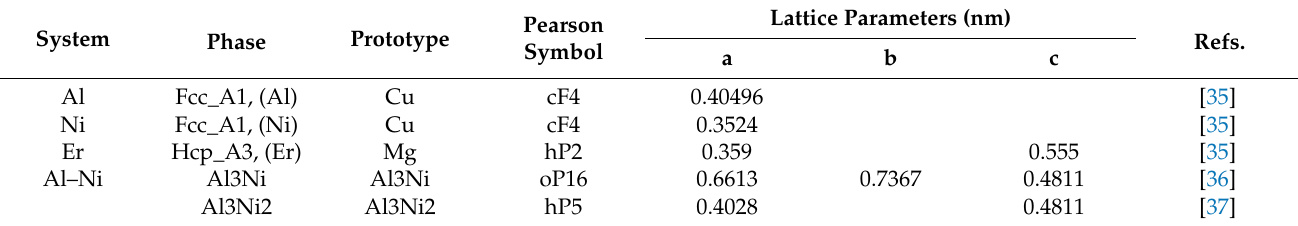
Table 1. Crystallographic data of all phases in the Al–Ni–Er